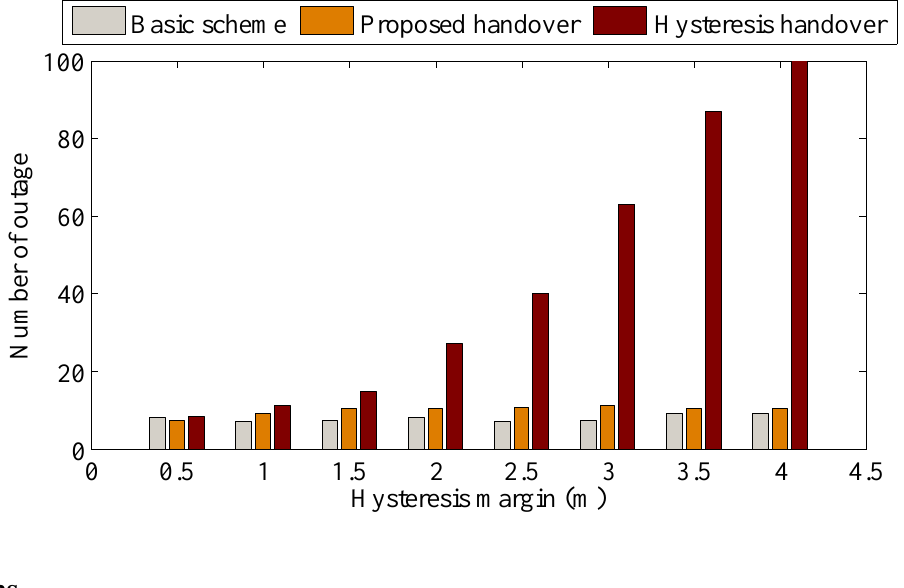
Figure 11. Comparison of the number of outage in the BSN deployment case with constructive constraints. Basic scheme Proposed handover Hysteresis